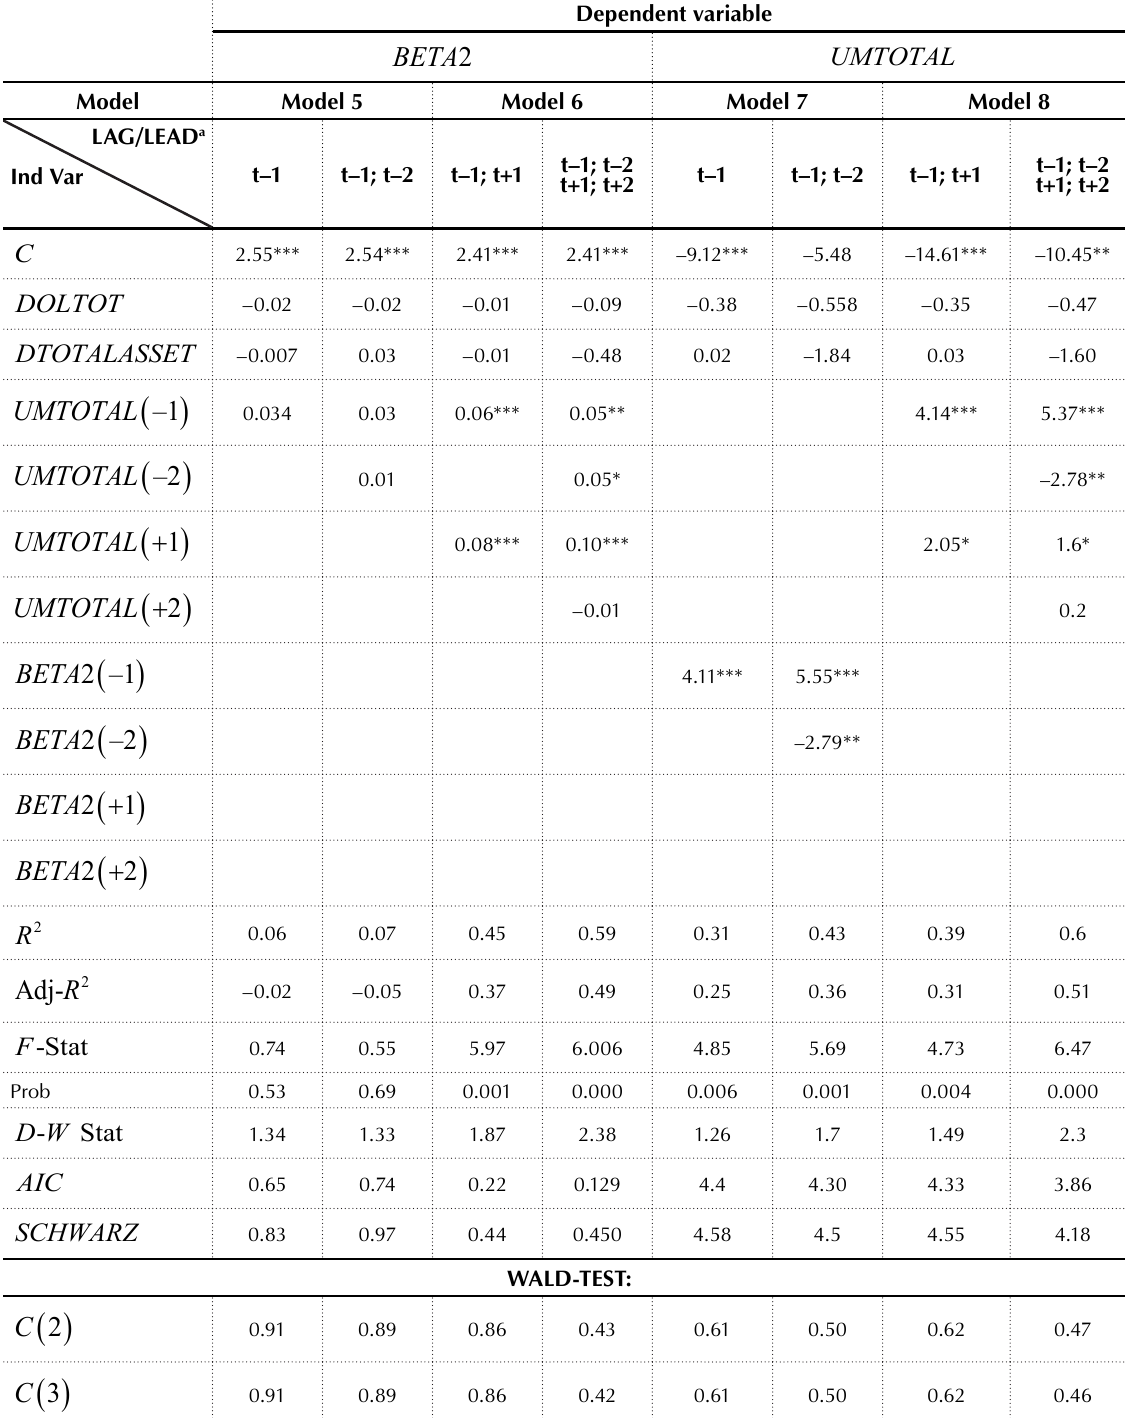
Table 5. The estimation results for models 5, 6, 7, and 8 (beta is adjusted)